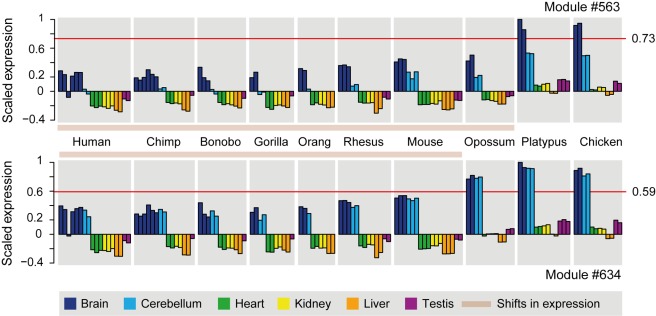
Concerted downregulation of X-linked and autosomal genes in the brain of placental and marsupial (i.e., therian) mammals.Modules with specific expression states in the therian brain (module 563; 330 genes) or eutherian brain/cerebellum (module 634; 313 genes) are shown. Bars represent the weighted average expression of all genes in a module, for each sample (horizontal grey line, average bar height). The horizontal red line represents the cutoff of the biclustering algorithm; samples above the red line are considered to have a distinct expression state. Note that the modules shown are highly enriched for X-linked genes (module 563: 25 observed versus 8.5 expected, p<10−3; module 634: 28 observed versus 8.3 expected, p<10−4), as are modules 421, 507, 521, and 618, which display transcriptional downregulations in therians or eutherians and were all considered in the protein–protein interaction analyses (see main text and Methods). All modules can be explored in a searchable database: http://www.unil.ch/cbg/ISA/species.